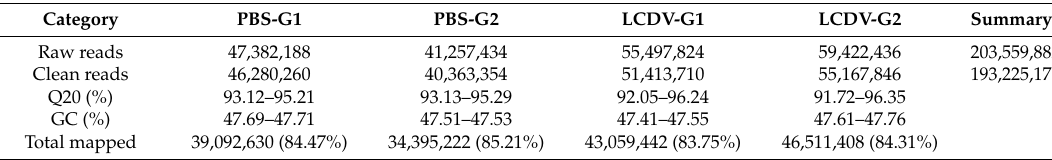
Table 2. Summary of sequences analysis.